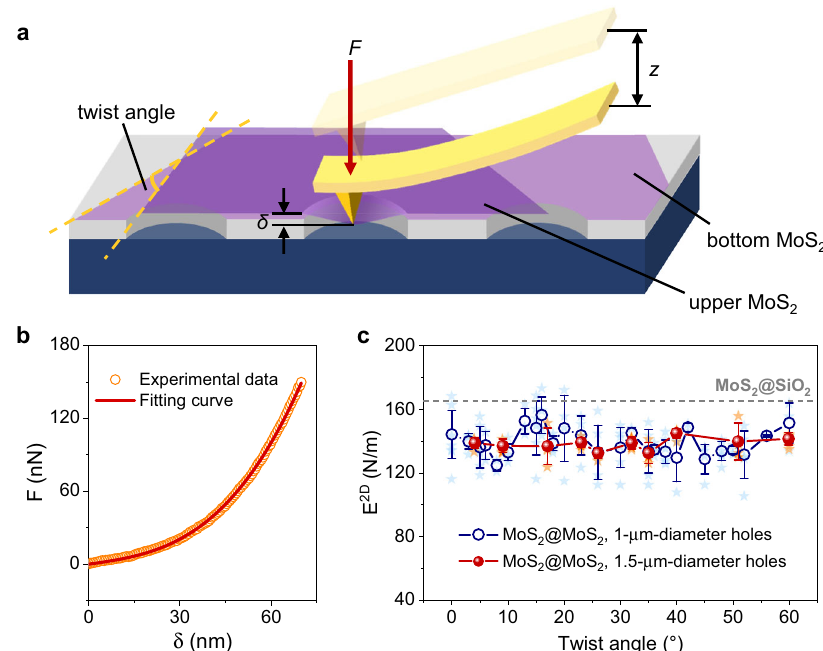
Fig. 2 Nanoindentation experiments of TBLM. a Schematic diagram of nanoindentation tests. F is the point force applied to the suspended region of the sample, z is the moving distance between the tip and the sample, and δ is the indentation depth of the suspended membrane. b Typical F - δ curve (orange circles) of a TBLM sample with the red line showing a fi tting of the F - δ curve following Eq. (1). c Dependence of measured in-plane elastic moduli of TBLM on twist angles. Blue stars and orange stars mark the measured moduli of each suspended membrane over 1- μ m-diameter and 1.5- μ m-diameter holes, respectively. The blue circles and red spheres are the corresponding average values. Error bars represent standard deviations. The gray dashed line represents the in-plane moduli of monolayer MoS 2 on SiO 2